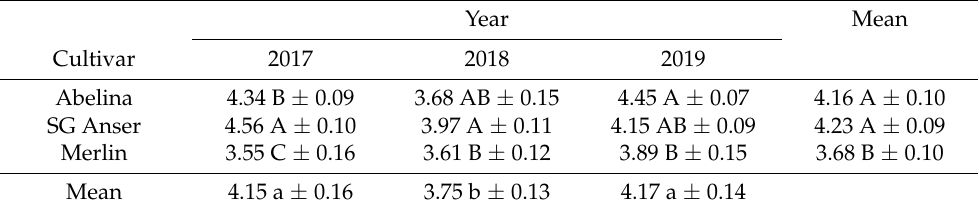
Figure 4. Pod number per plant according to biostimulants and cultivars in 2017 – 2019. Means followed by different letters in lowercase: a and b differ significantly at p ≤ 0.05; ± Se (standard error) value. Table 7. Pod length according to years and cultivars